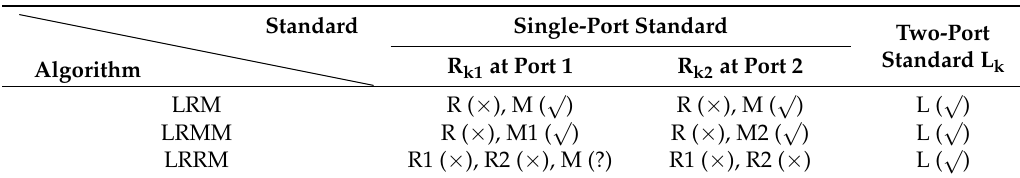
Table 1. Standards used for